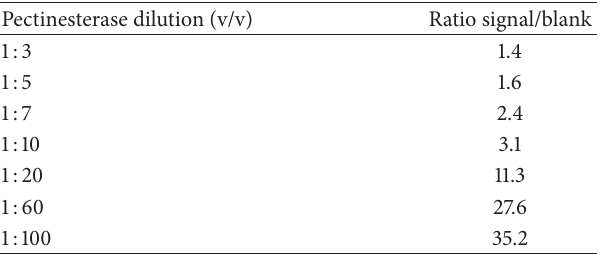
Table 1: Effect of pectin methylesterase commercial preparation activity on the analytical